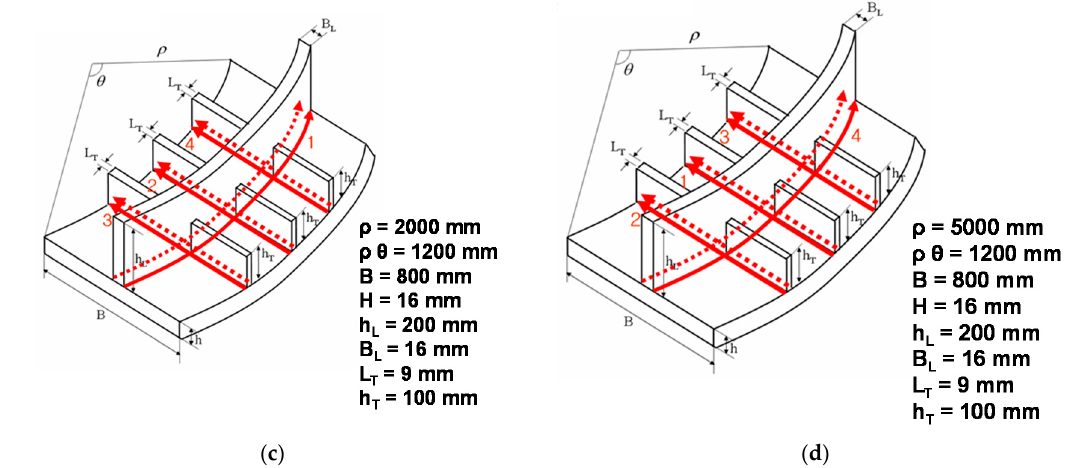
Figure 10. Experimental models with the welding sequences: ( a ) first experimental model: CASE 1; ( b ) second experimental model: CASE 2; ( c ) third experimental model: CASE 3; ( d ) fourth experimental model: CASE 4.